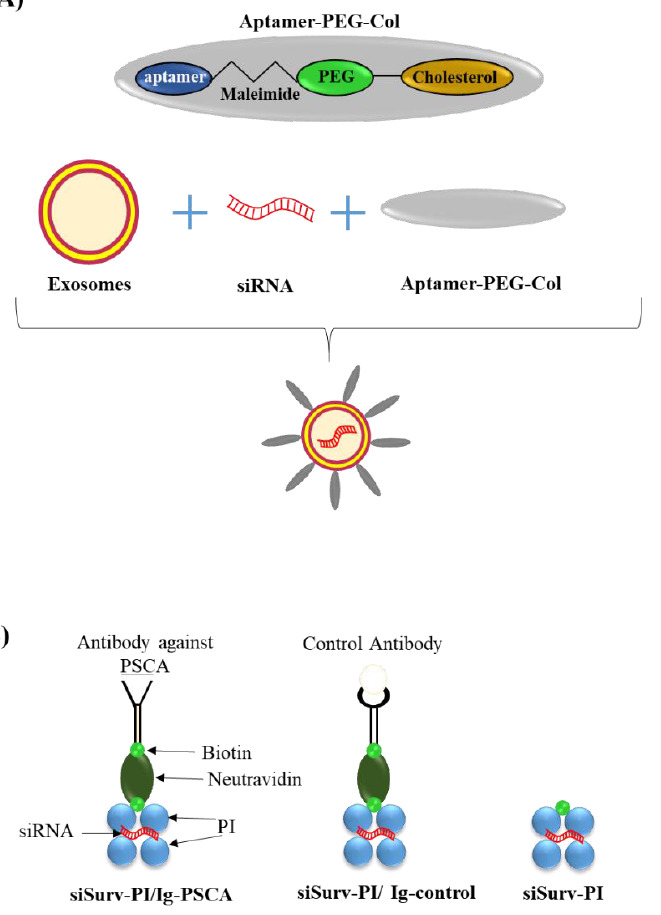
Figure 5. SiRNA delivery complexes in PC. ( A ) Exosome surface was modified by the addiction of AptE3 linked to maleimide-PEG-cholesterol molecules, from [91]. ( B ) Delivery system developed in [94]: It contains maltose-modified poly(propylene imine) polymers (PI) linked to biotin and loaded with siSurv (siSurv-PI). siSurv-PI was bound to an anti PSCA antibody linked to biotin (Ig-PSCA);